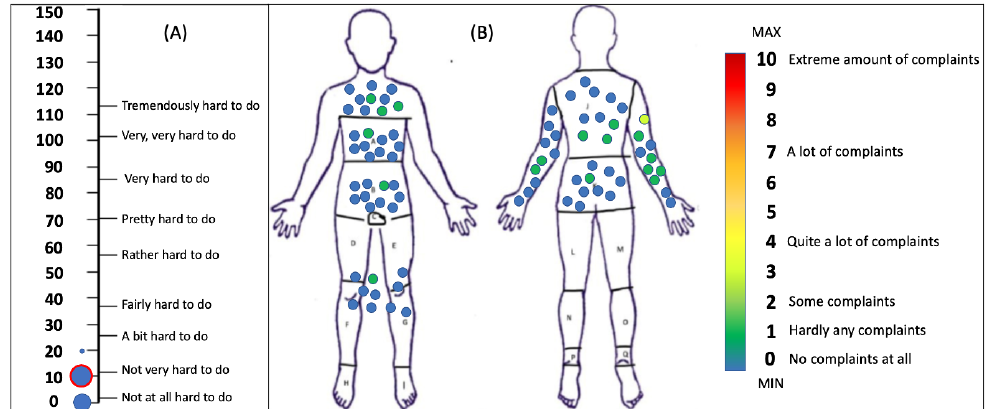
Figure 8. ( A ) All answers to the Subjective Mental Effort Questionnaire (SMEQ) by system validation trials participants. The size of the circles denotes the relative number of answers, while the red circle denotes median marking. ( B ) All answers to the Locally Experienced Discomfort Questionnaire (LED) by system validation trials participants were according to body area. Both legs are denoted as a single area, and so are the front and back surface of either arm. The colour inside the circles corresponds to the complaint intensity according to the